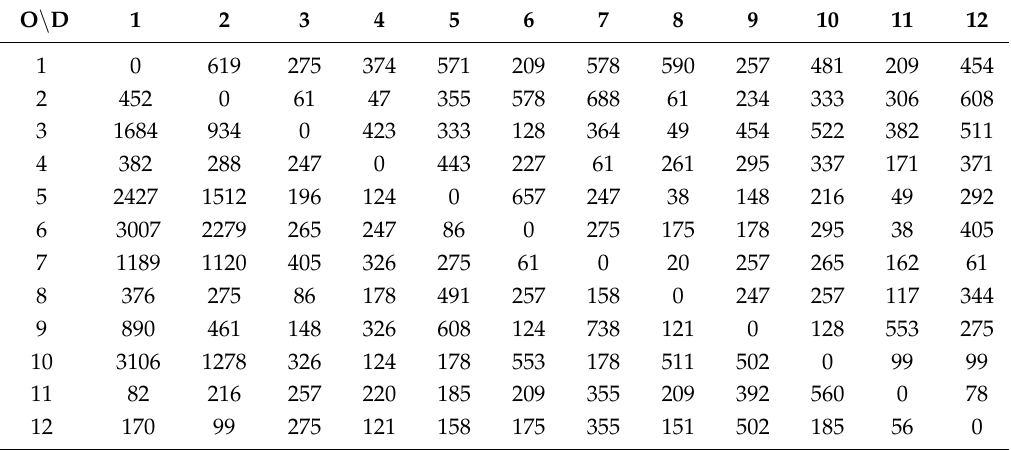
Table 3. OD-passenger matrix during the peak hour 7:00–8:00 of the Changping line. O \